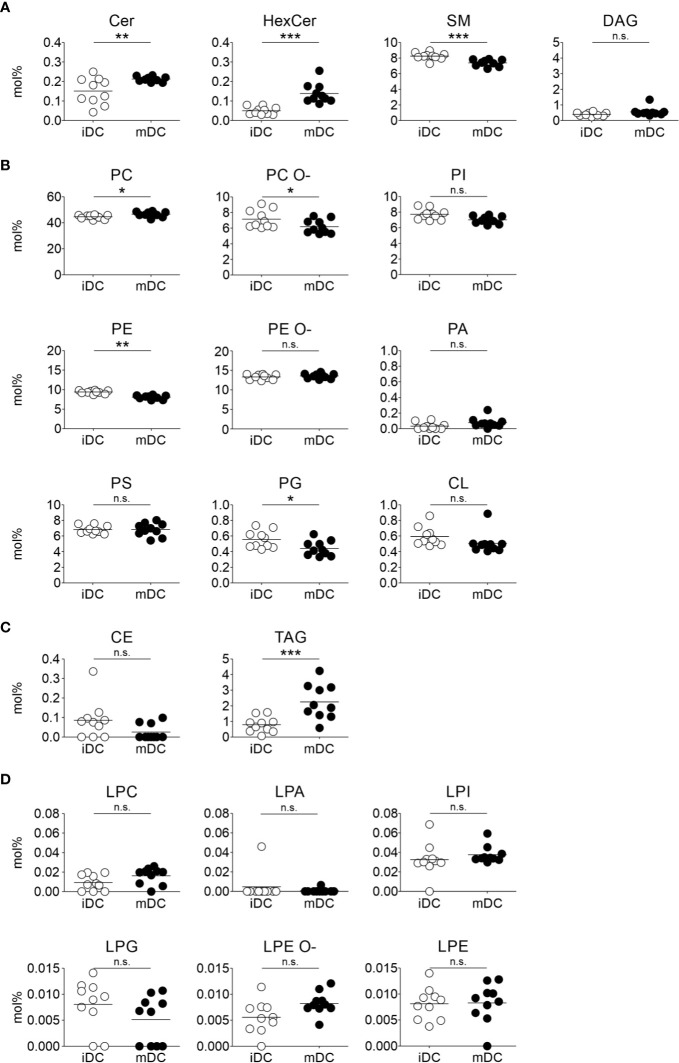
Lipid class changes upon maturation of moDCs. Mass spectrometric analysis of total lipid composition of immature and mature moDCs was carried out. Scatter plots demonstrate lipid class amounts for immature and mature moDCs of all donors. The amount of a lipid class (mol%) is calculated by summing the pmol values of the individual lipids belonging to each class. The class amount was then normalized to total lipid content. Horizontal lines represent mean values of the biological replicates. Content of membrane lipids is divided in (A) sphingolipids and glycerolipids, and (B) glycerophospholipids. (C) Lipid content of storage lipids and (D) messenger lipids in immature and mature moDCs. Statistical significances were calculated using ANOVA (n≥10). Not significant (n.s.) p > 0.05, *p < 0.05, **p ≤ 0.01, ***p ≤ 0.001.